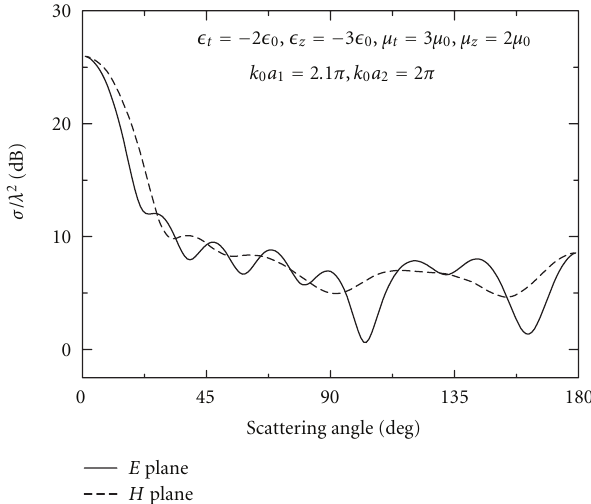
Figure 3: Radar cross-sections (RCSs) versus scattering angle θ (in degrees) in the E -plane (solid curve) and in the H -plane (short- dashed curve).